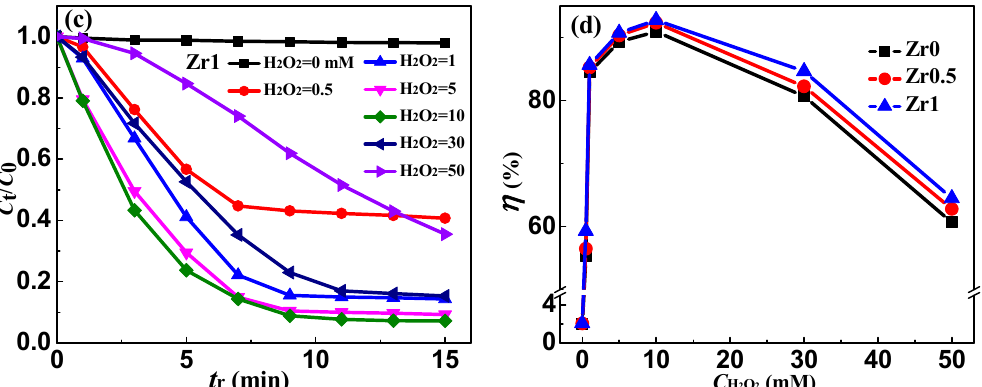
Figure 7. The normalized concentration C t / C 0 change of MB solution during the degradation process of the as-spun ( a ) Zr0, ( b ) Zr0.5 and ( c ) Zr1 ribbons at different H 2 O 2 concentration. ( d ) The degradation efficiency ( η = (1 − C t / C 0 × 100%, t = 15 min) of the degradation process vs. C H2O2 for Zr0, Zr0.5 and Zr1 ribbons.